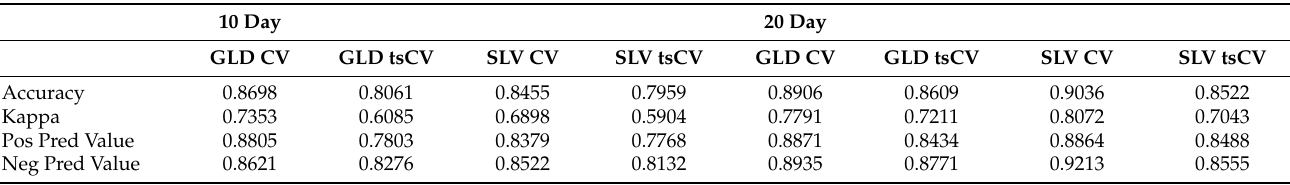
Table 3. Comparing CV with tsCV from random forests